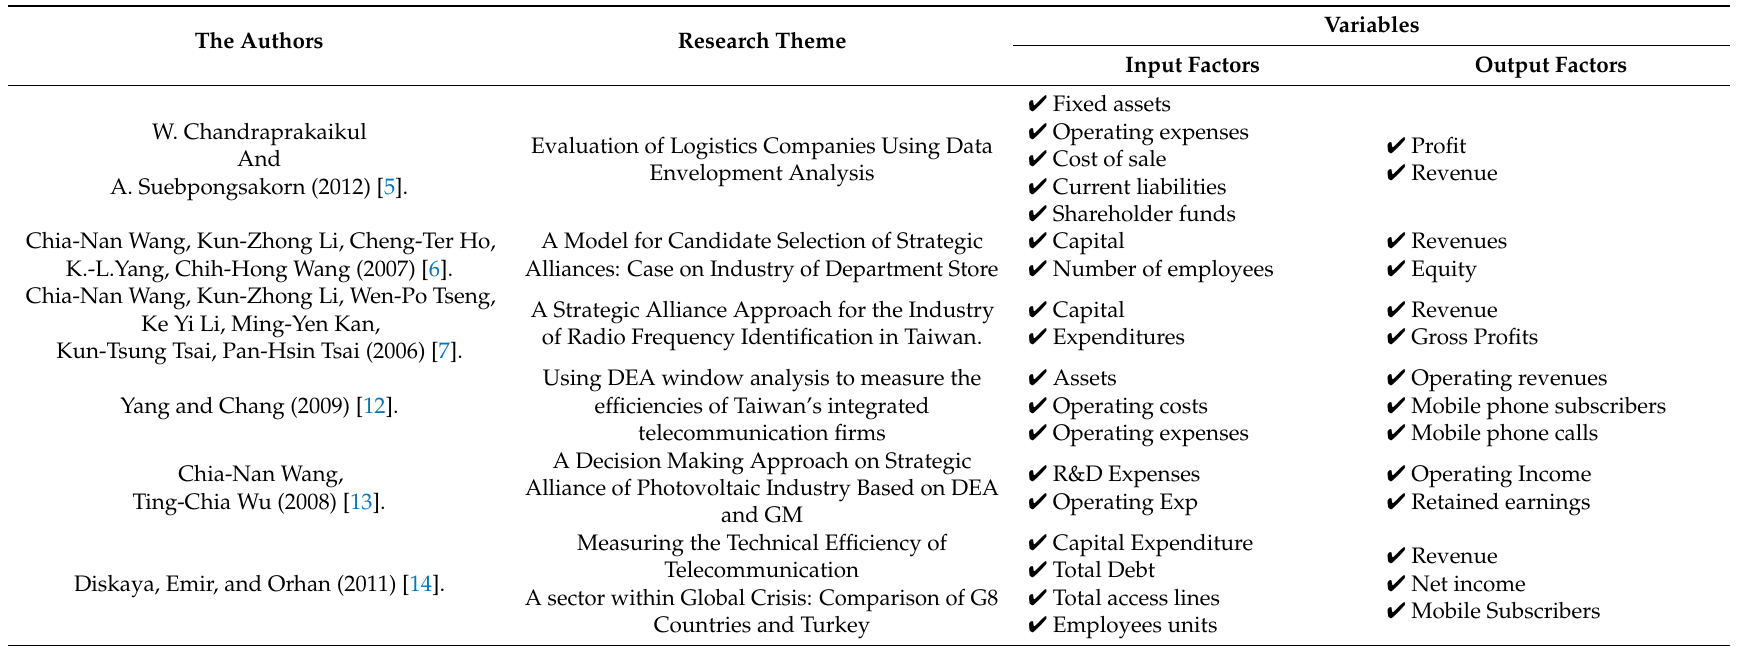
Table 3. Input and output variable selection using Data Envelopment Analysis